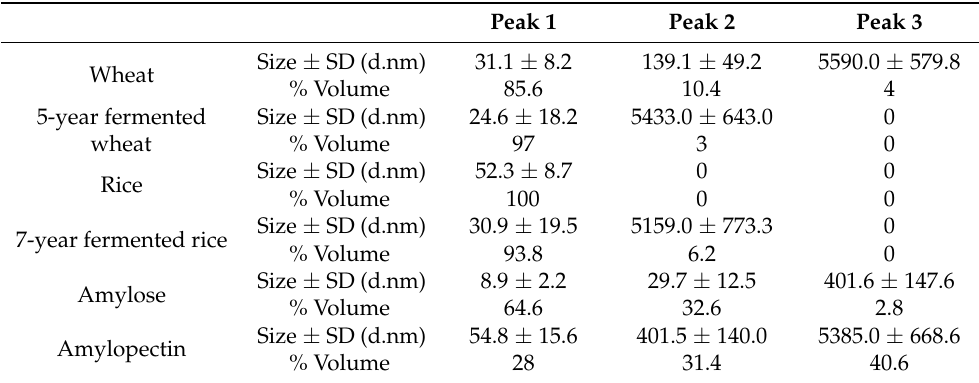
Figure 1. Size distribution by volume of: ( a ) fresh wheat starch and 5-year fermented wheat starch; and ( b ) fresh rice starch and 7-year fermented rice starch. Table 1. Size and percentage volume of four different types of starch particle and amylose and amylopectin.